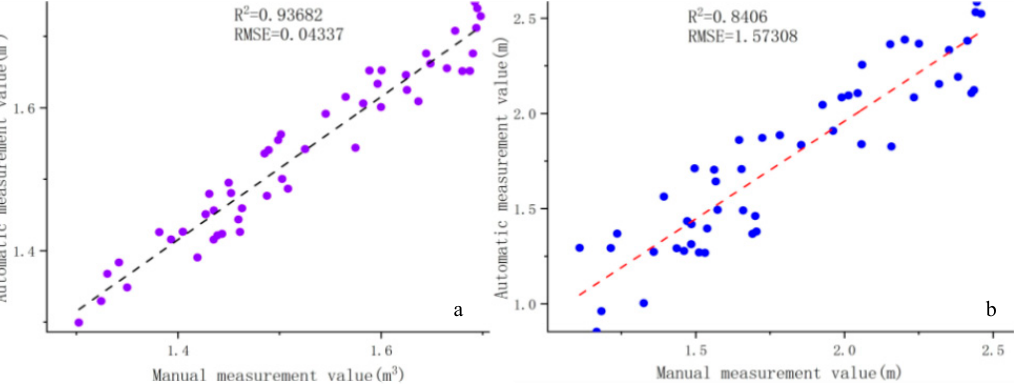
Figure 10. Comparison of manually measured values and automatically calculated values: ( a ) the comparison of tree height parameters and ( b ) the comparison of canopy volume.